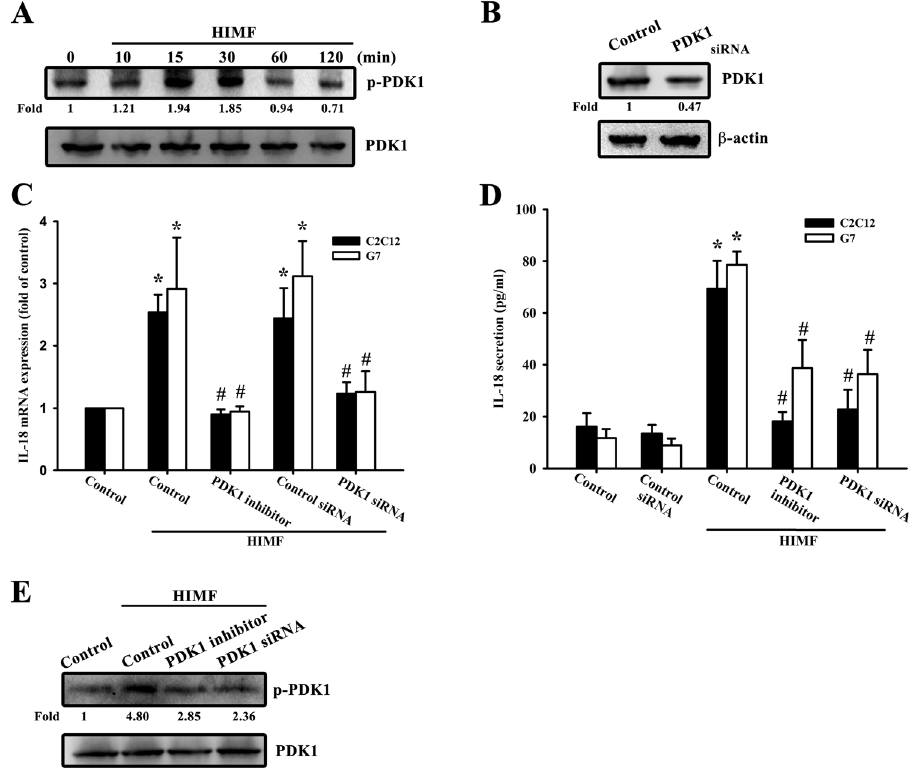
Figure 2. PDK1 is involved in HIMF-induced IL-18 production. ( A ) Cells were incubated with HIMF (3 nM) for indicated time intervals and cell lysates were immunoblotted with an antibody specific for phospho-PDK1. ( B ) Cells were transfected with a PDK1 siRNA for 24 h, and PDK1 protein expression was analyzed. ( C ) HIMF- induced IL-18 mRNA was inhibited by a PDK1 inhibitor or PDK1 siRNA. ( D ) Cells were pretreated for 30 min with a PDK1 inhibitor or transfected with siRNA against PDK1 for 24 h, then stimulated with HIMF for 24 h, and the conditioned media was collected and examined by ELISA. ( E ) HIMF-induced PDK1 phosphorylation was inhibited by a PDK1 inhibitor or PDK1 siRNA. Results are expressed as the means ± SEM of four independent experiments. * p < 0.05 as compared with the control group. # p < 0.05 as compared with HIMF- treated